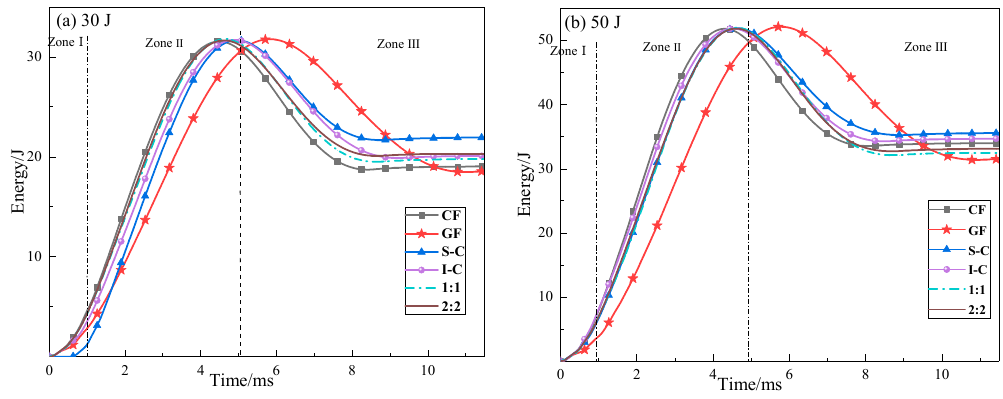
Figure 4. Energy vs. time response of composite specimens at ( a ) 30 J and ( b ) 50 J.